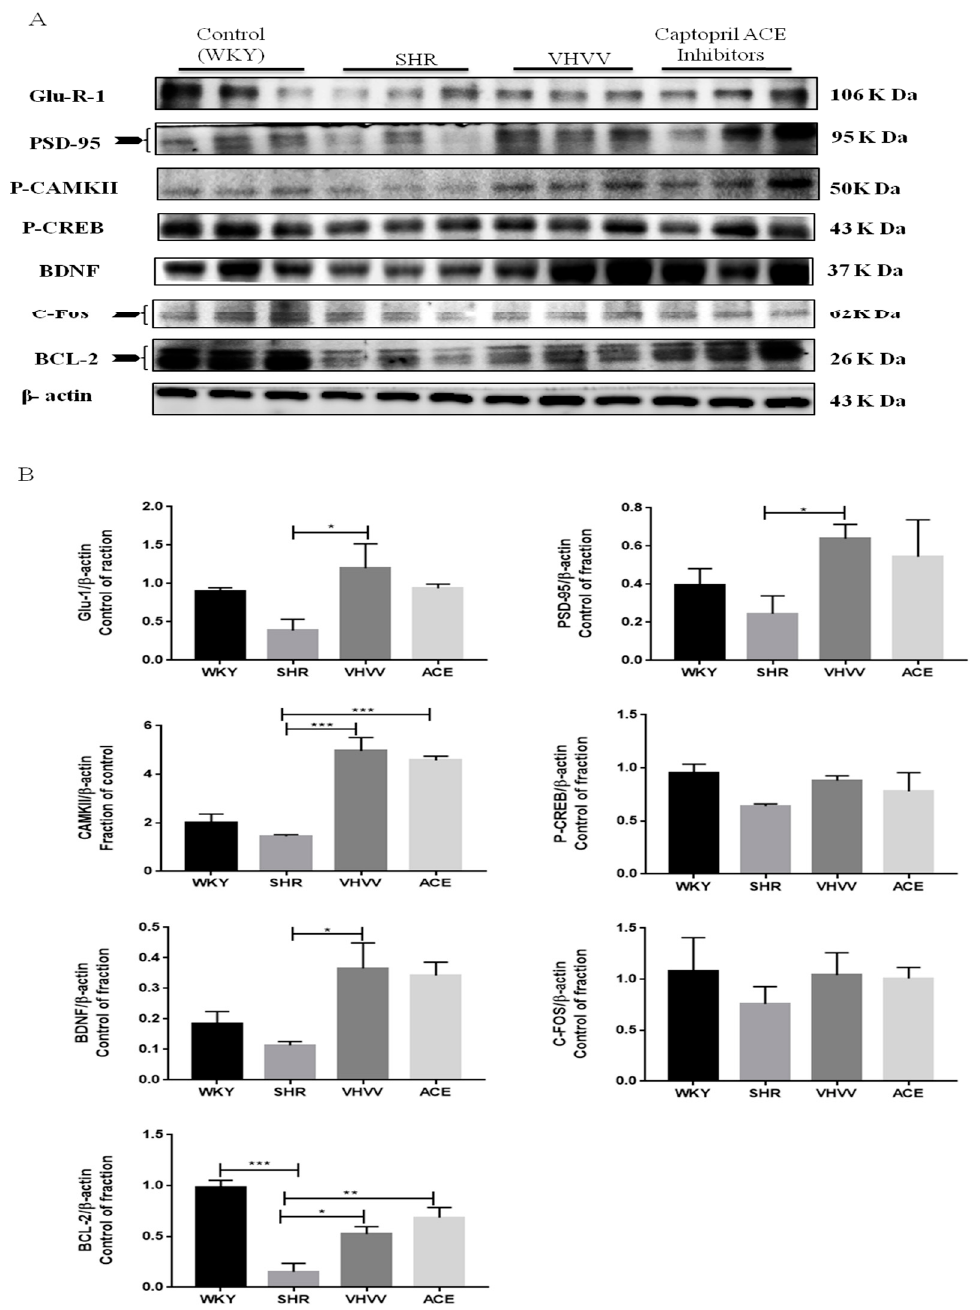
Figure 3. Protein expression levels of L-glutamate receptor 1 (Glu-R-1), postsynaptic density protein 95 (PSD-95), phosphor-Ca 2 + / calmodulin-dependent protein kinase II (P-CamKII), phosphor- cAMP response element binding protein (CREB) / brain-derived neurotrophic factor (BDNF), C-Fos, and b-cell lymphoma-2 (BCL-2) and the corresponding Western blot analysis in the cortex of SHRs and WKY rats. ( A ) Long-term memory (LTM) progressively increased in bioactive peptide VHVV-treated animals compared with the positive control ACE inhibitor and control WKY groups. The 24-week SHR groups were significantly di ff erent from the VHVV- and ACE inhibitor-treated animals. ( B ) Quantification of Figure 3A. β -actin was used to monitor protein quantification as an internal control. The data are presented as the mean ± standard error. * p < 0.05, ** p < 0.01 and *** p < 0.001 .